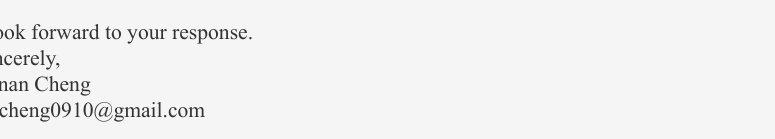
Figure 6. Email template for reporting abusive domains to registrars.